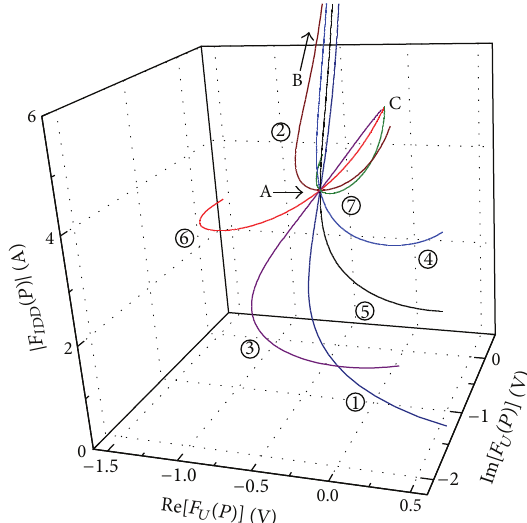
0.0 Figure 8: 3D fault model of the Sallen-key filter by DFT. Point A means the fault free status of all 𝐹 𝑖 -loci, and some 𝐹 𝑖 -loci are tendency to an infinity point B.